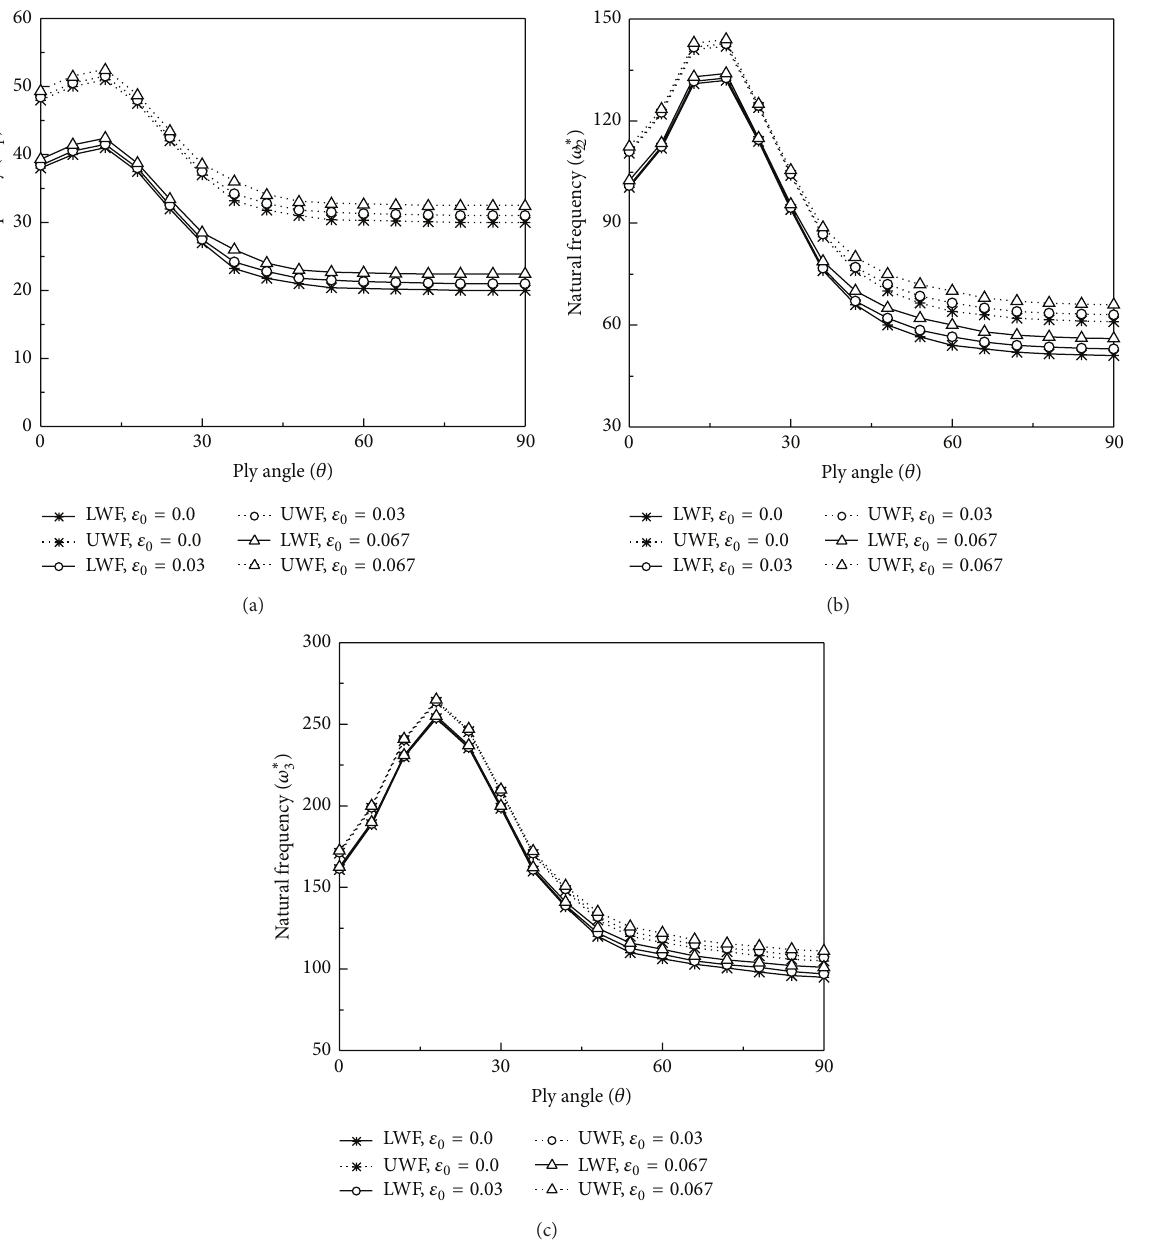
Figure 8: The first three natural frequencies versus ply-angle for the different initial strains of SMA wire ( 𝜃 = 30 ∘ ; 𝑇 = 50 ∘ C; 𝑉 𝑠 = 0.36 ).